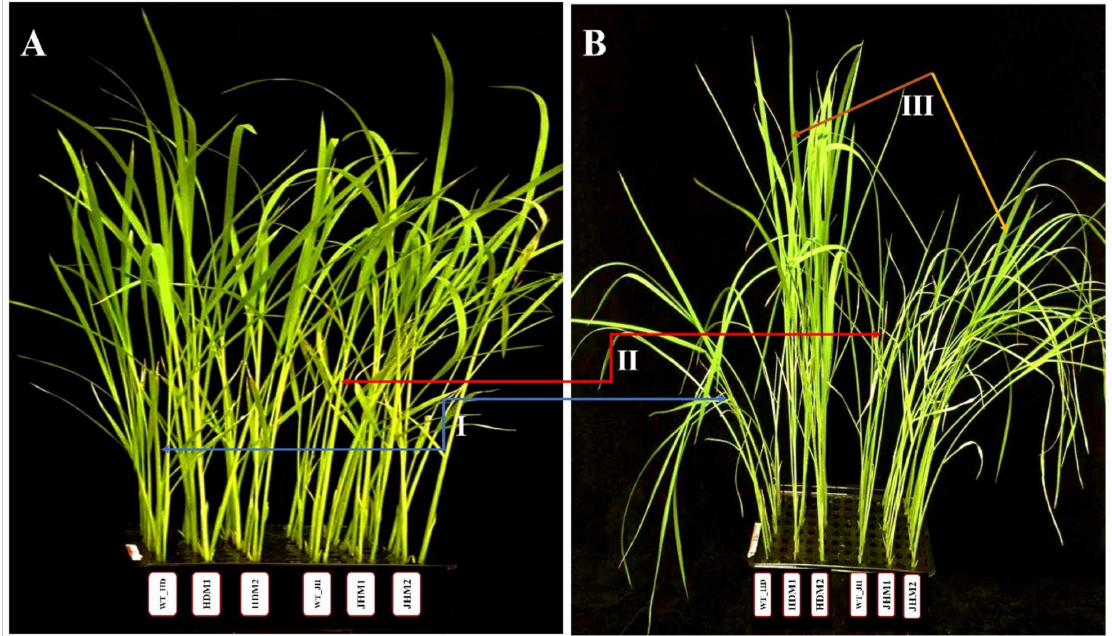
Figure 2. Phenotypic changes in wild-type and mutant lines under salinity treatment: ( A ) control (nontreated); ( B ) 100 mM NaCl treated (after 96 h). WT_HD, Huaidao#5 wild type; HDM1, Huaidao#5 mutant line 1; HDM2, Huaidao#5 mutant line 2; WT_JH, Jiahua#1 wild type; JHM1, Jiahua#1 mutant line 1; JHM2, Jiahua#1 mutant line 2. The blue arrow (I) shows phenotype changes in Huaidao#5, the red arrow (II) shows changes in Jiahua#1, and the brown and yellow arrows (III) show changes among mutant